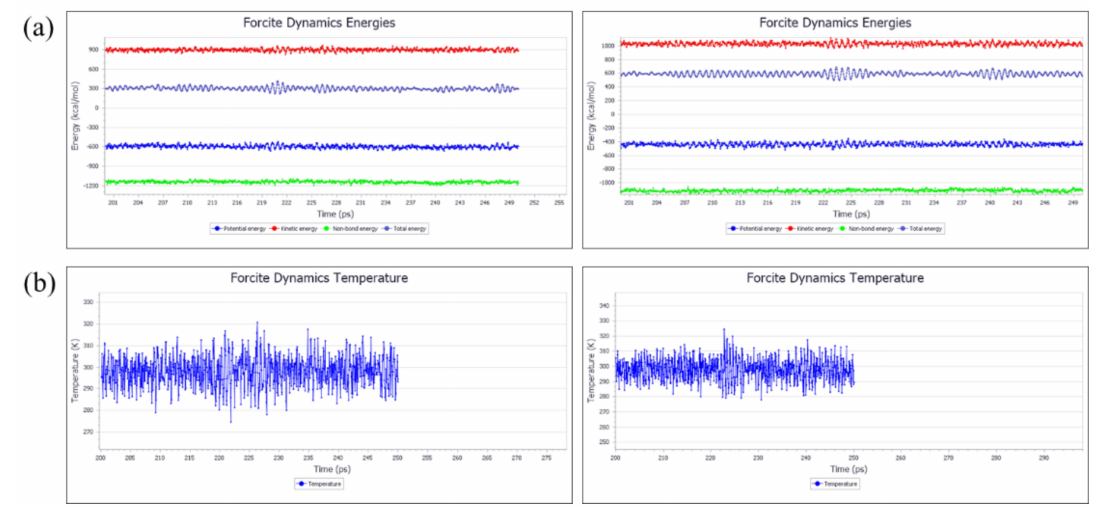
Figure 6. ( a ) Energy fluctuation curves of proanthocyanidins at NVT-MD simulation time (left, trimer; right, heptamer); ( b ) temperature fluctuation curves of proanthocyanidins at NVT-MD simulation time (left, trimer; right,